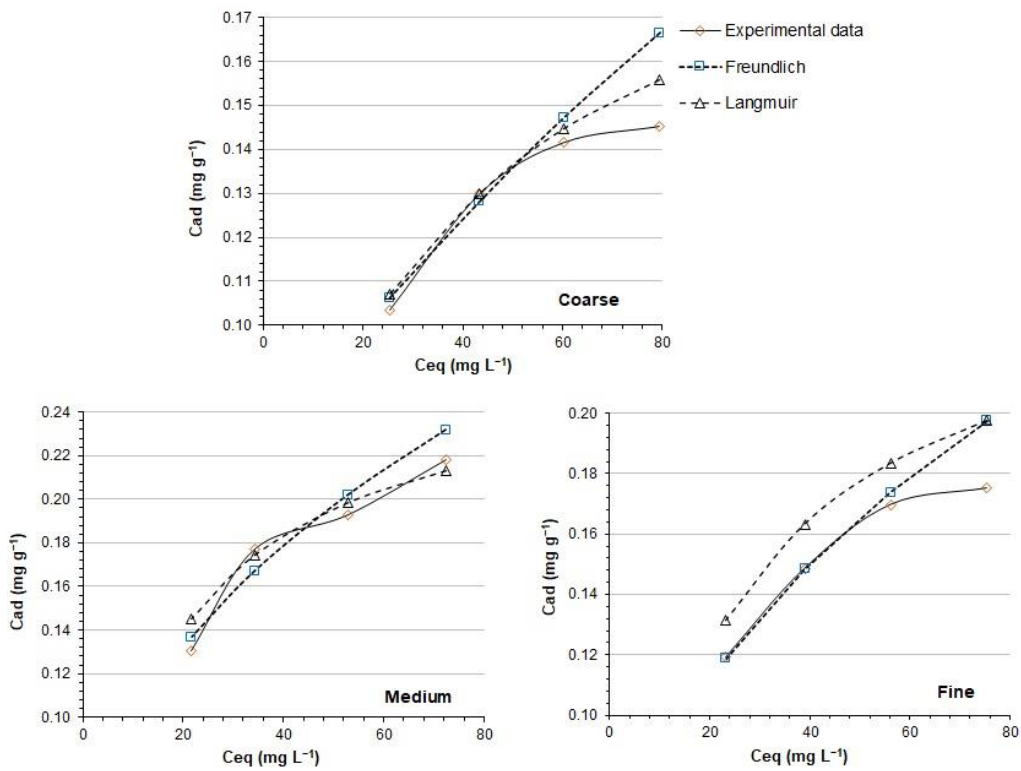
Figure 5. Adsorption isotherms for phosphate ions on adsorbent substrates prepared with the three granulometric fractions of material and activated with H 2 SO 4